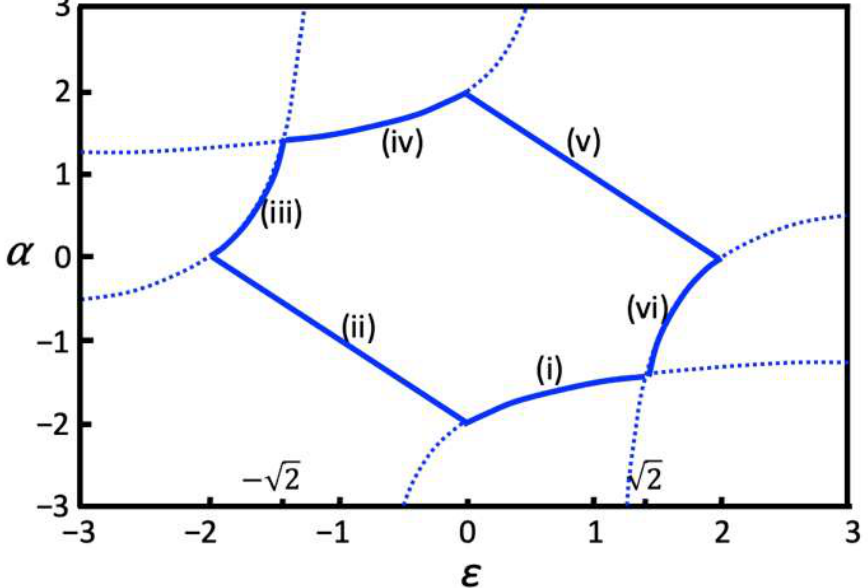
Figure 4. Two-parameter bifurcation diagram for the interaction scheme shown in Figure 1a . Oscil- lations occur for ε and α parameter values along solid curves marked as (i)–(v). To demonstrate agreement between numerical and analytical solutions, the dotted curves are drawn by plotting the following functions: α = − ( ε + 2)/( ε + 1) and α = ( ε − 2)/( ε − 1), which overlap with solid curves (iii), (i) and (iv), (vi) obtained numerically in corresponding regions.